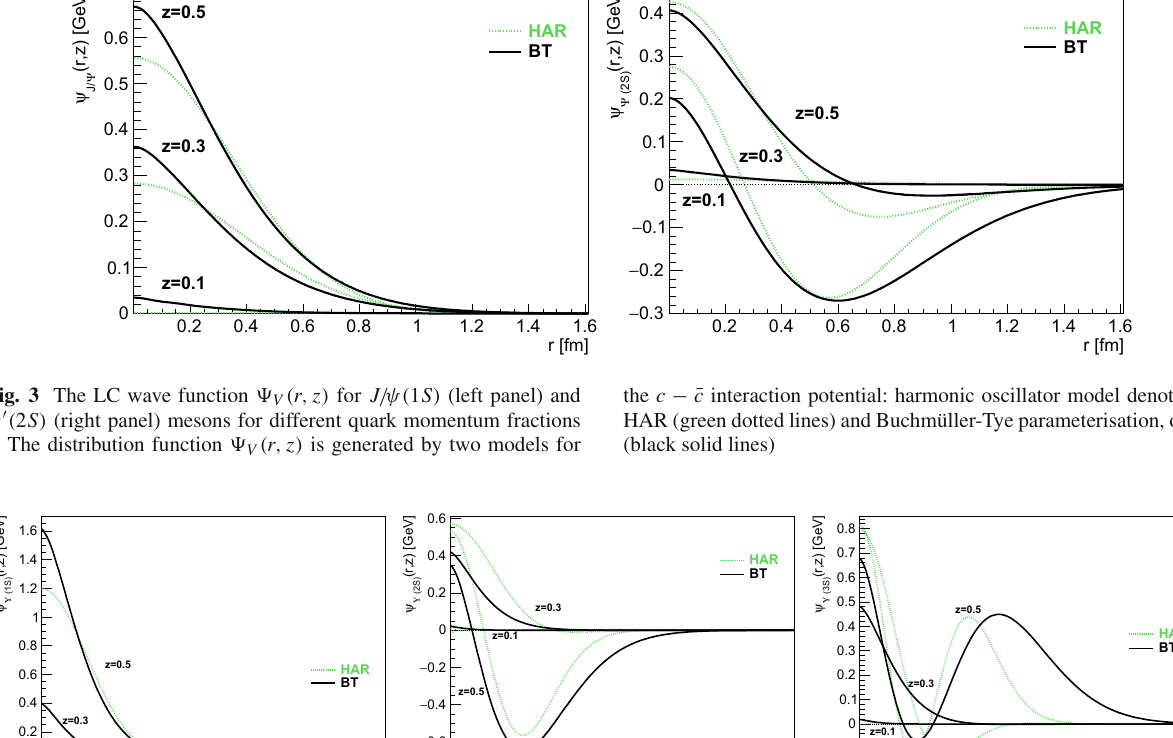
of the potential. The corresponding LC wave functions for ϒ( 1 S ) , ϒ (cid:2) ( 2 S ) and ϒ (cid:2)(cid:2) ( 3 S ) mesons are shown in Fig.